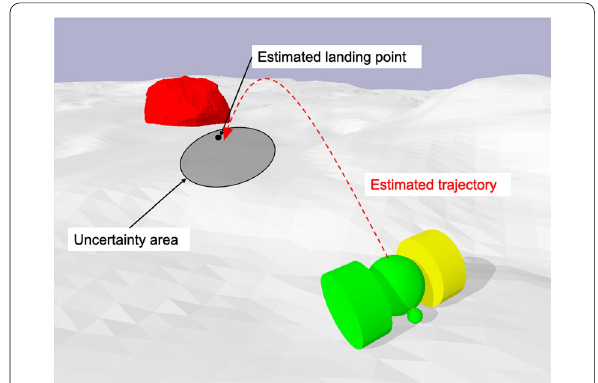
Fig. 2 The image of the hopping with